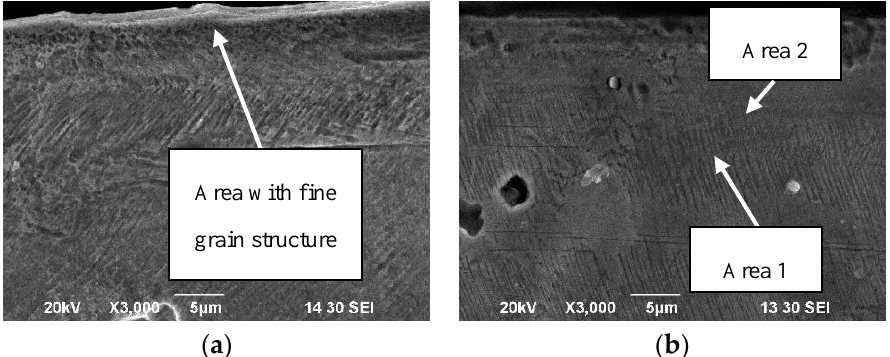
Figure 6. Wear surface microstructure, 0.29%V: ( а ) as cast; ( b ) after heat treatment.